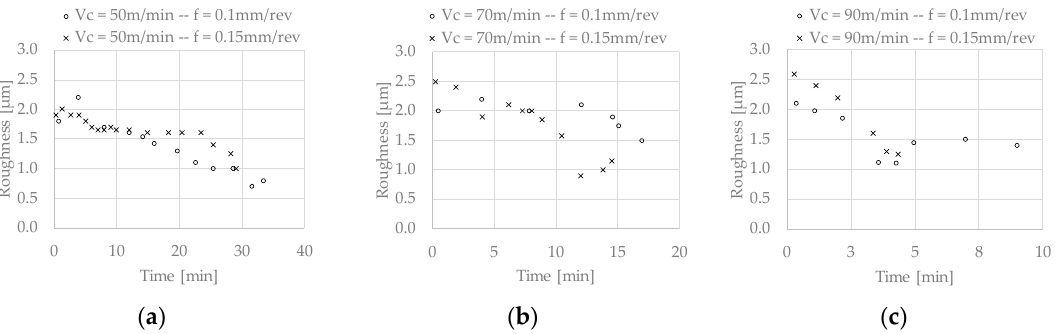
Figure 5. Machined surface roughness for all of the tested cutting parameters: ( a ) cutting speed = 50 m/min; ( b ) cutting speed = 70 m/min; ( c ) cutting speed = 90 m/min.